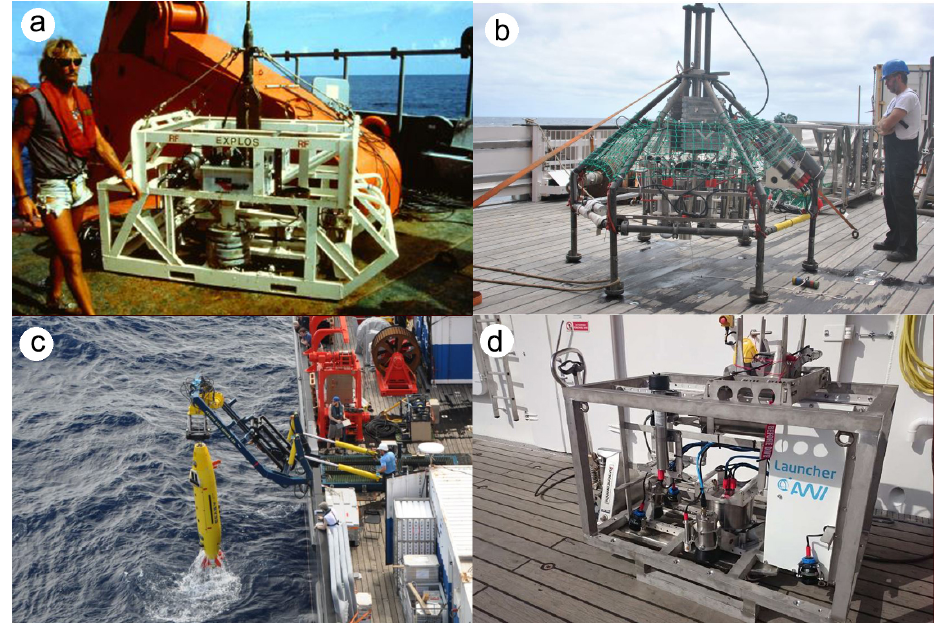
Figure 3. Imaging platforms used in the current study. (a) The EXPLOS OFOS analogue camera sled from 1997 (Schriever and Thiel, 1992).